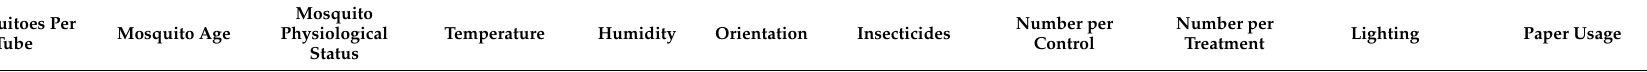
Table 2. Summary of the review of historic versions of the World Health Organization (WHO) tube bioassay guidelines. * Initial baseline dose response for population generated with range of concentrations. Subsequent testing uses four concentrations along this range and two controls. Testing is performed in duplicate. ** Mortality in a negative control over 20% is unsatisfactory; testing should be repeated. A section to help with interpreting dose response curves is also introduced. *** Initial baseline preliminary test performed with full range, then concentrations selected for baseline assessment. Subsequent routine checks used a concentration which is double the concentration that has consistently given complete kill in successive tests. Exposure time can be increased for exceptionally insensitive populations. (2, 4